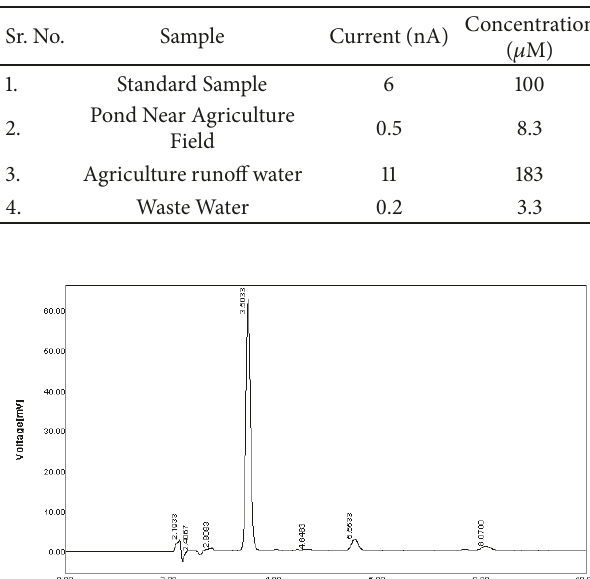
Table 2: Analysis of water samples using the newly fabricated sensor.